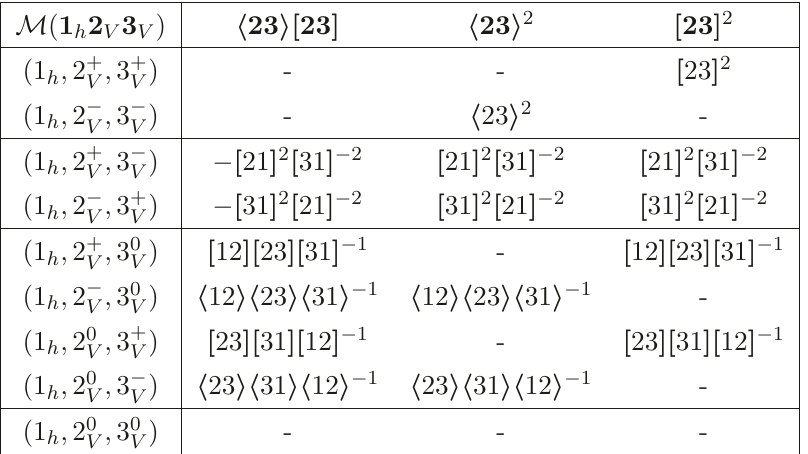
( 1 h 2 V 3 V ) amplitude. M ( m 3 /E 3 ). The SMEFT coefficients were omitted for O